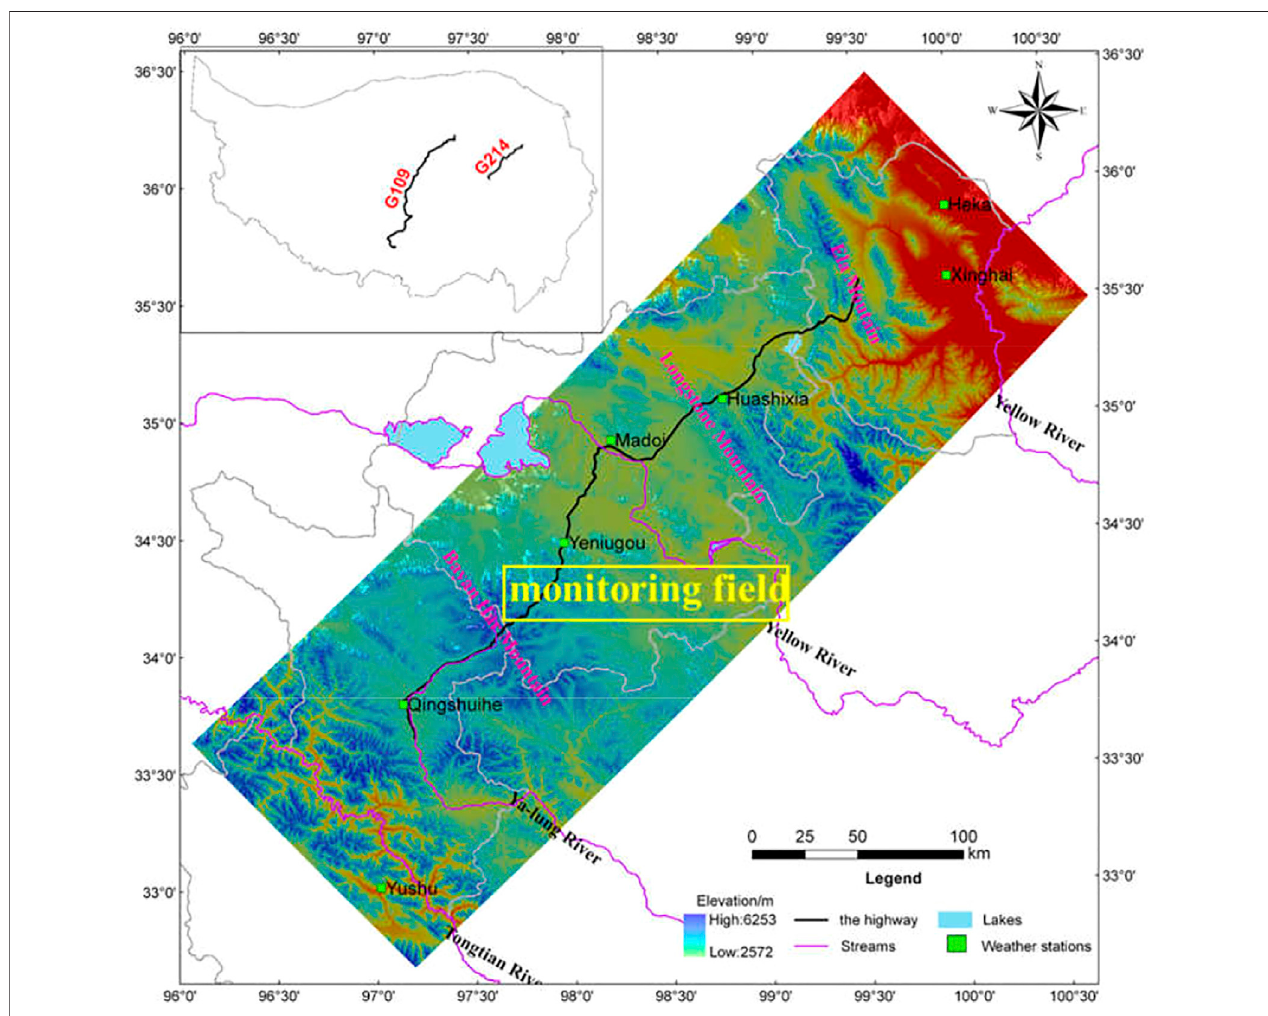
FIGURE 2 | Location of monitoring fi